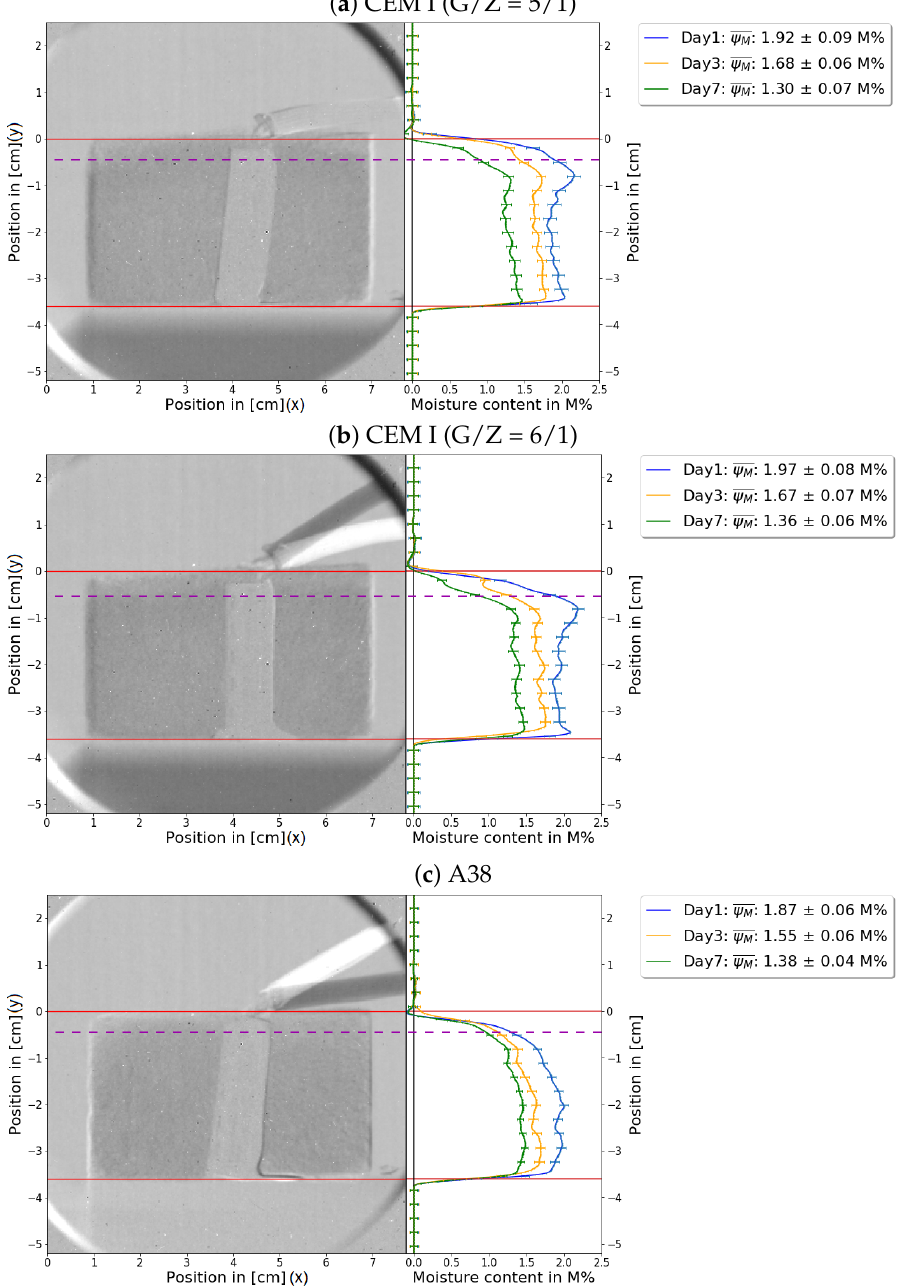
Figure 3. This figure shows the location dependent water content of all samples at 1 day (blue), 3 days (orange), and 7 days (green) after preparation. To compare NR measurements to the established methods, the average water content ψ M is shown in the legend. The average water content ψ M is calculated according to the equation: ψ M = ∑ sample ψ Mx ÷ x , where ∑ sample involves all indices i in the sample. The orange box in Figure 2d shows the values used to calculate these averages. The red orientation lines indicate the top and the bottom of the sample. The electronic sensor is placed in the middle of the sample. The fibres connecting the sensor to the voltmeter can also be seen on top of the sample. Since the cable was moved between measurements, there is a strong contrast around the fibre. The depth analysis of the drying process of the samples: ( a ) CEM I (G/Z = 5/1). ( b ) CEM I (G/Z = 6/1). ( c ) A38. The measurement shows unexpected results: A thin layer of disproportionate dryness was observed for each sample, which can be seen above the dashed purple